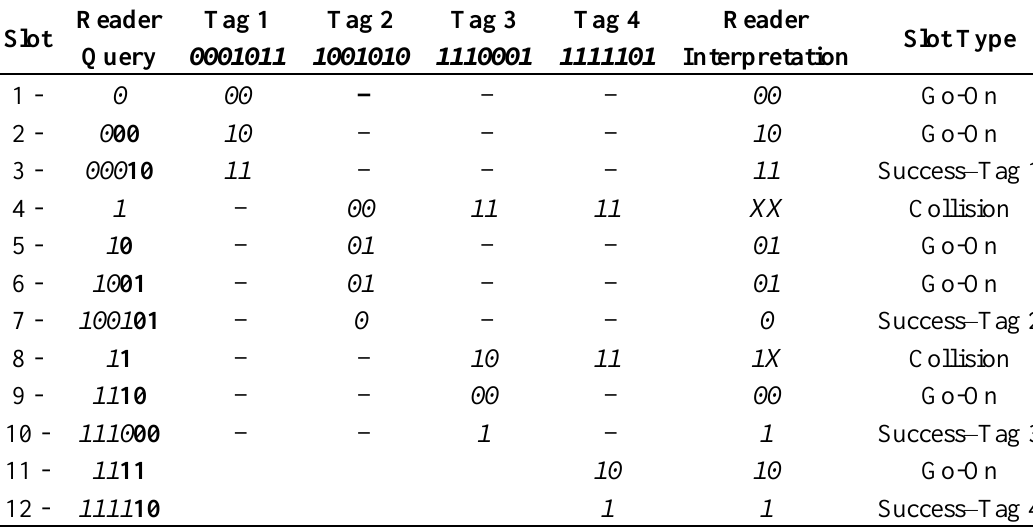
Table 1. Example of an identification cycle of CT with ws = 2